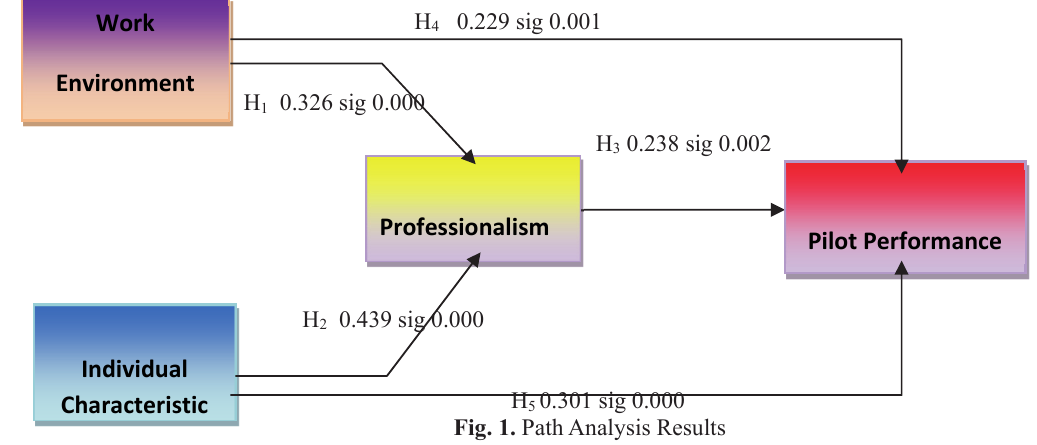
Fig. 1. Path Analysis